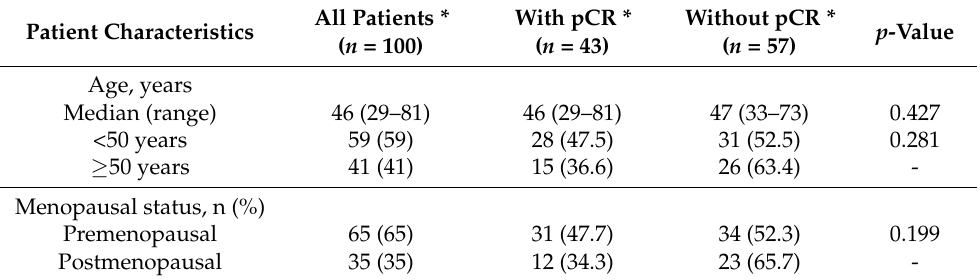
Table 1. Demographic and patient characteristics of total population and pCR